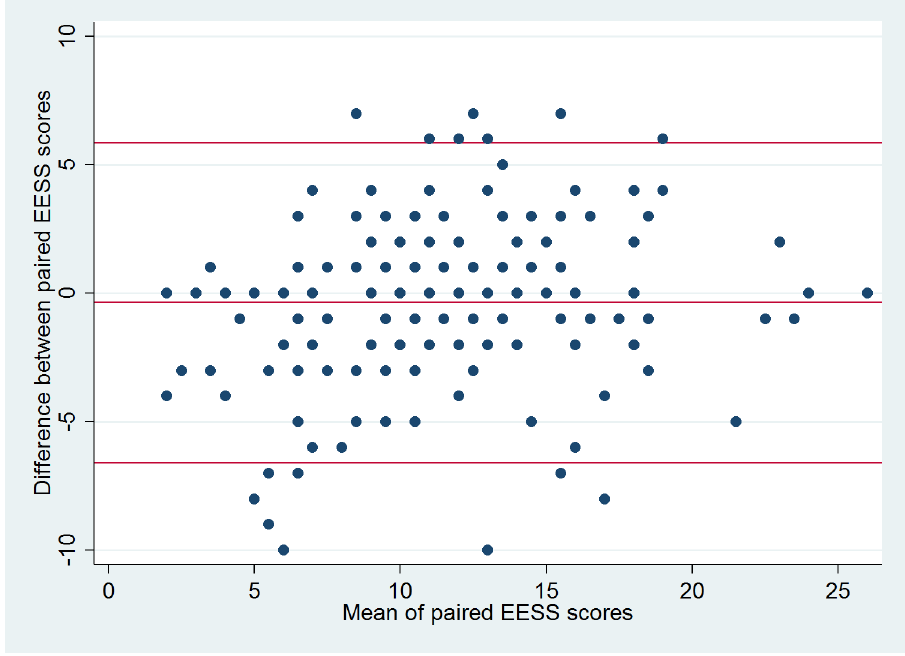
Fig 2. Bland-Altman plot of the two scores derived from the 10 item EESS at the first assessment.